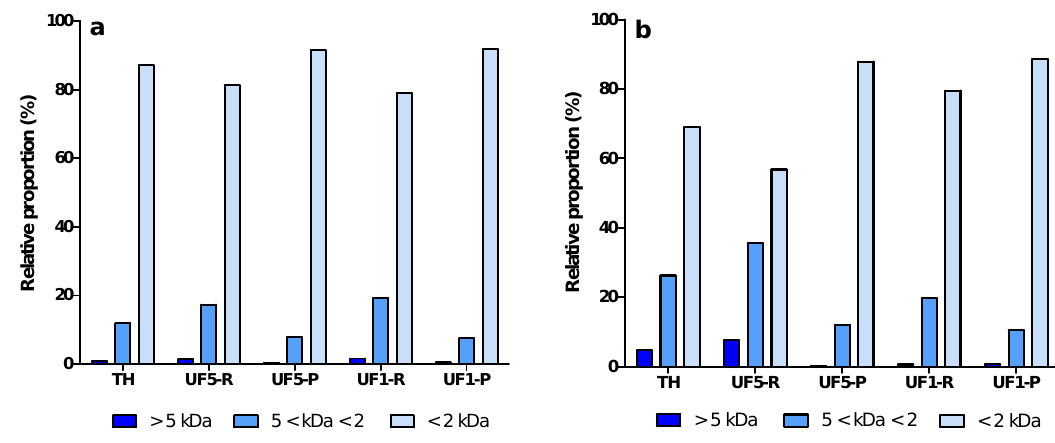
Figure 2. Molecular weight distribution profile (%) of protein/peptide components in total hydrolysates (TH) and their UF-fractions prepared from egg yolk proteins hydrolyzed with Alcalase and Protease N (a) and phophoproteins hydrolyzed with trypsin (b)